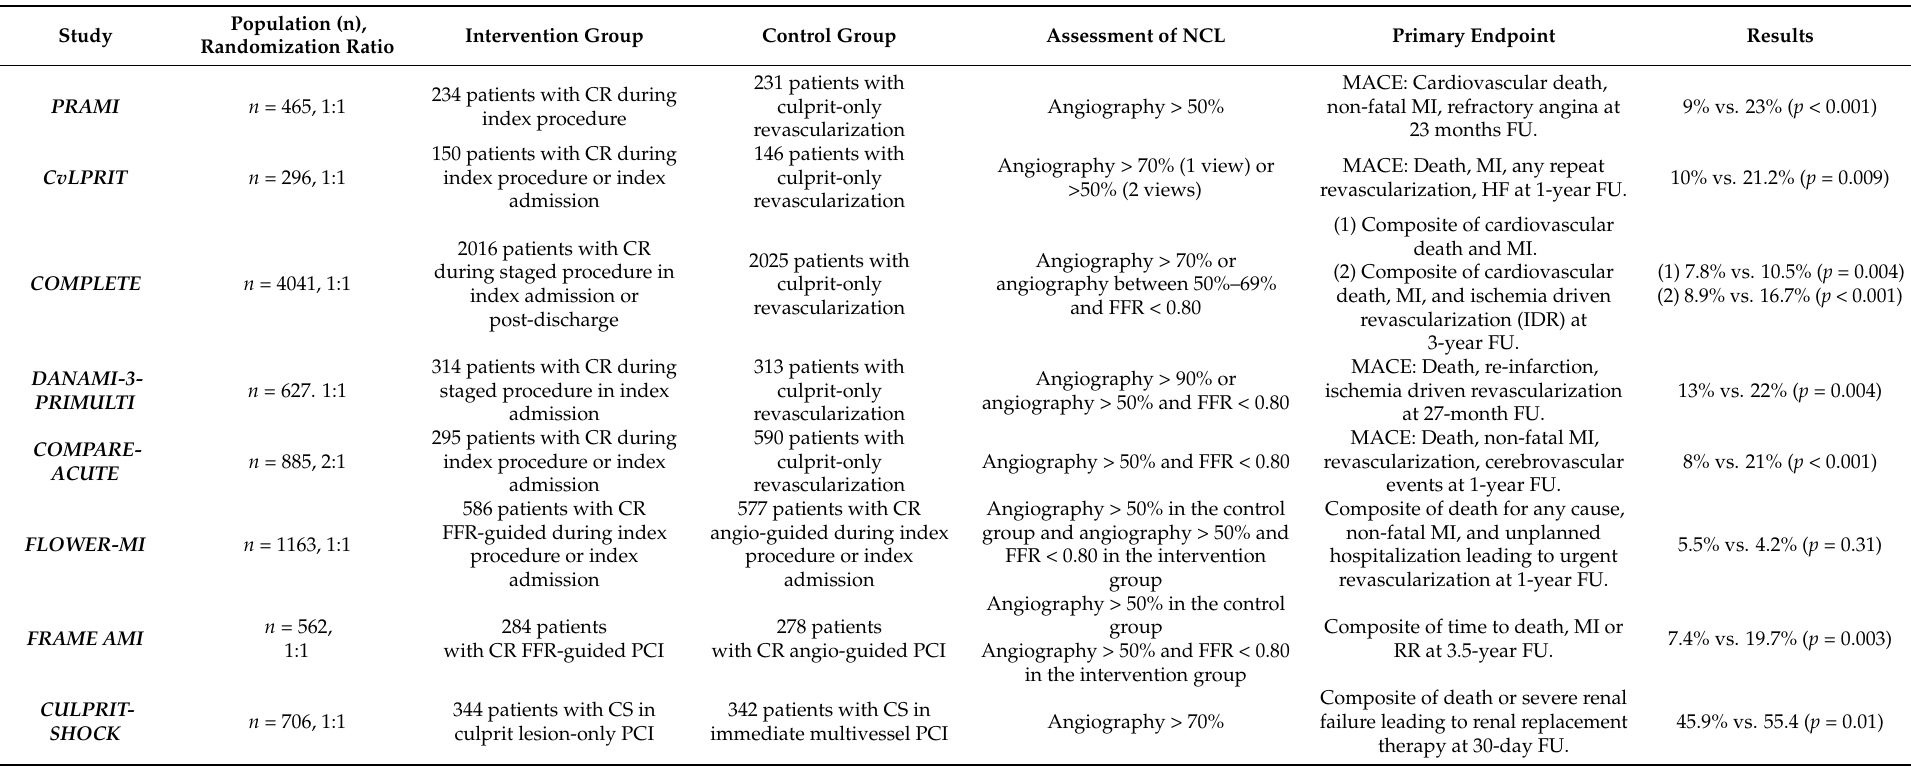
Table 1. Randomized controlled trials on culprit lesion-only PCI versus multivessel PCI. ACS, acute coronary syndrome; CR: complete revascularization; FFR: fractional flow reserve; FU: follow-up; IDR: ischemia driven revascularization; MACE: major adverse cardiovascular events; MI: myocardial infarction;